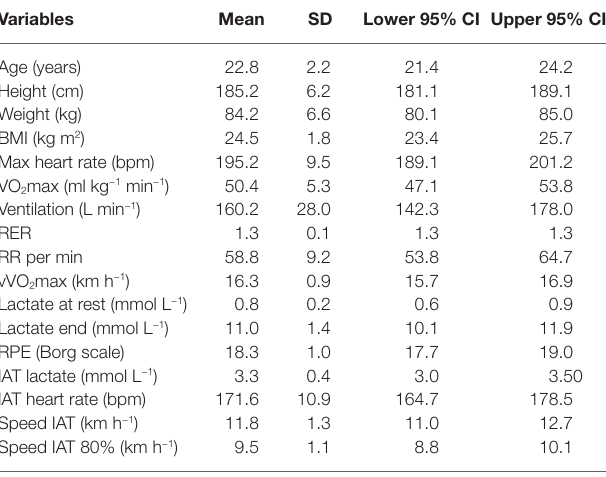
TABLE 1 | Mean descriptive results of participants’ data and results from the incremental exercise test, with SD and 95% confidence interval (CI).